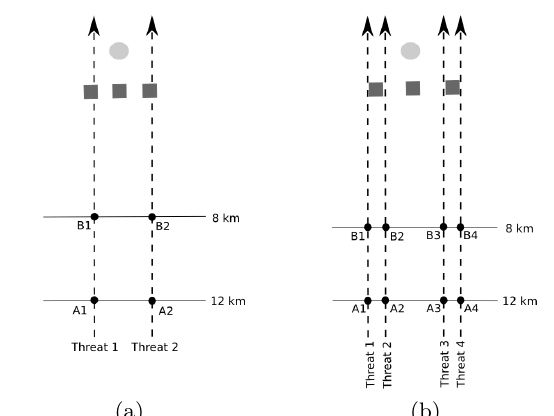
Figure 8: Scenario 2 for (a) survey questions 2.1–2.4 and (b) survey question 2.5.